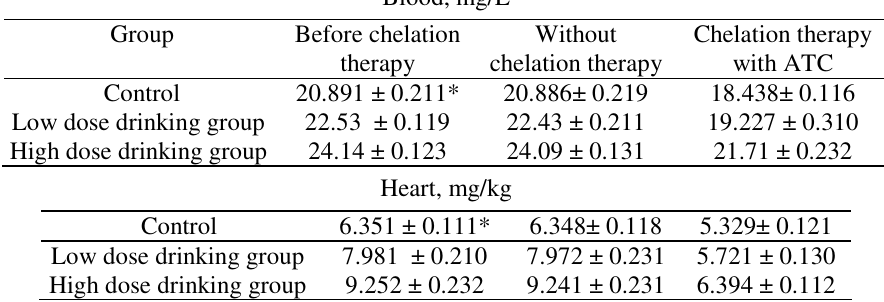
Table 3. The results of iron content before and after chelation therapies with